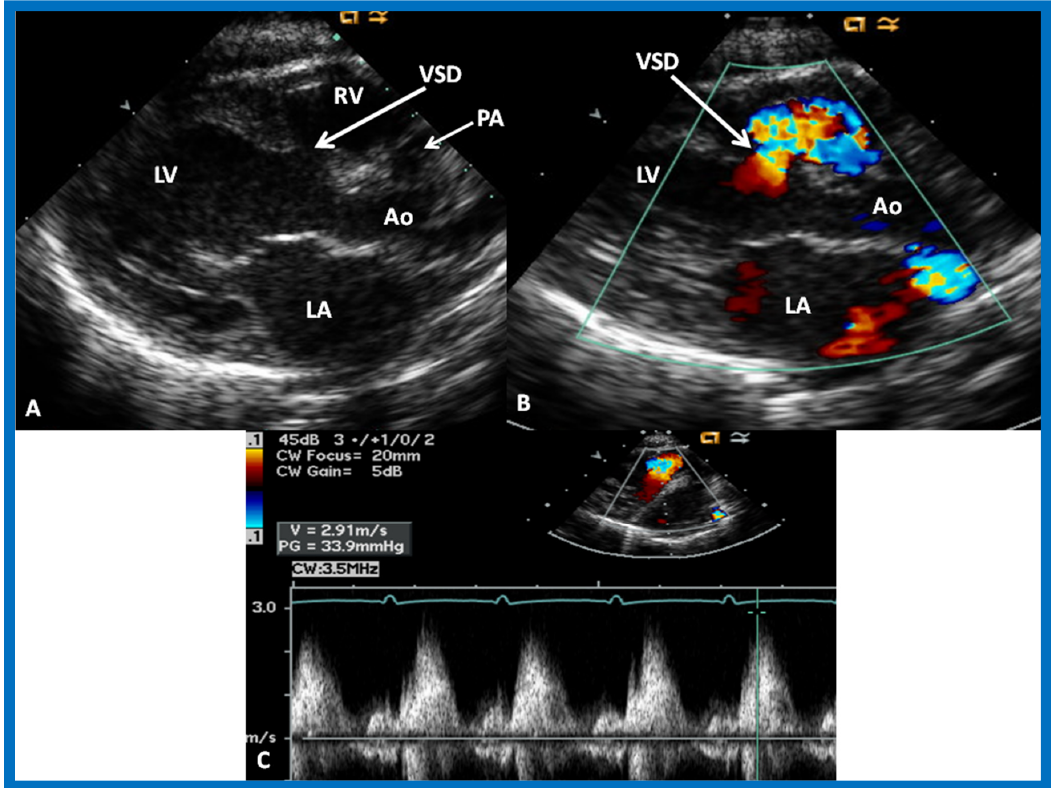
Figure 20. Selected video frames from precordial long axis views of a neonate with tricuspid atresia with normally related great arteries demonstrating enlarged left atrium (LA) and left ventricle (LV), a small right ventricle (RV) and a moderate sized ventricular septal defect (VSD) (thick arrow) on 2D ( A ) and color flow ( B ) imaging. Turbulent flow ( B ) with a Doppler flow velocity of 2.91 m/s by continuous wave Doppler ( C ) suggests some restriction of the VSD. Ao, Aorta; PA, pulmonary artery. Reproduced from Rao P.S. [39].